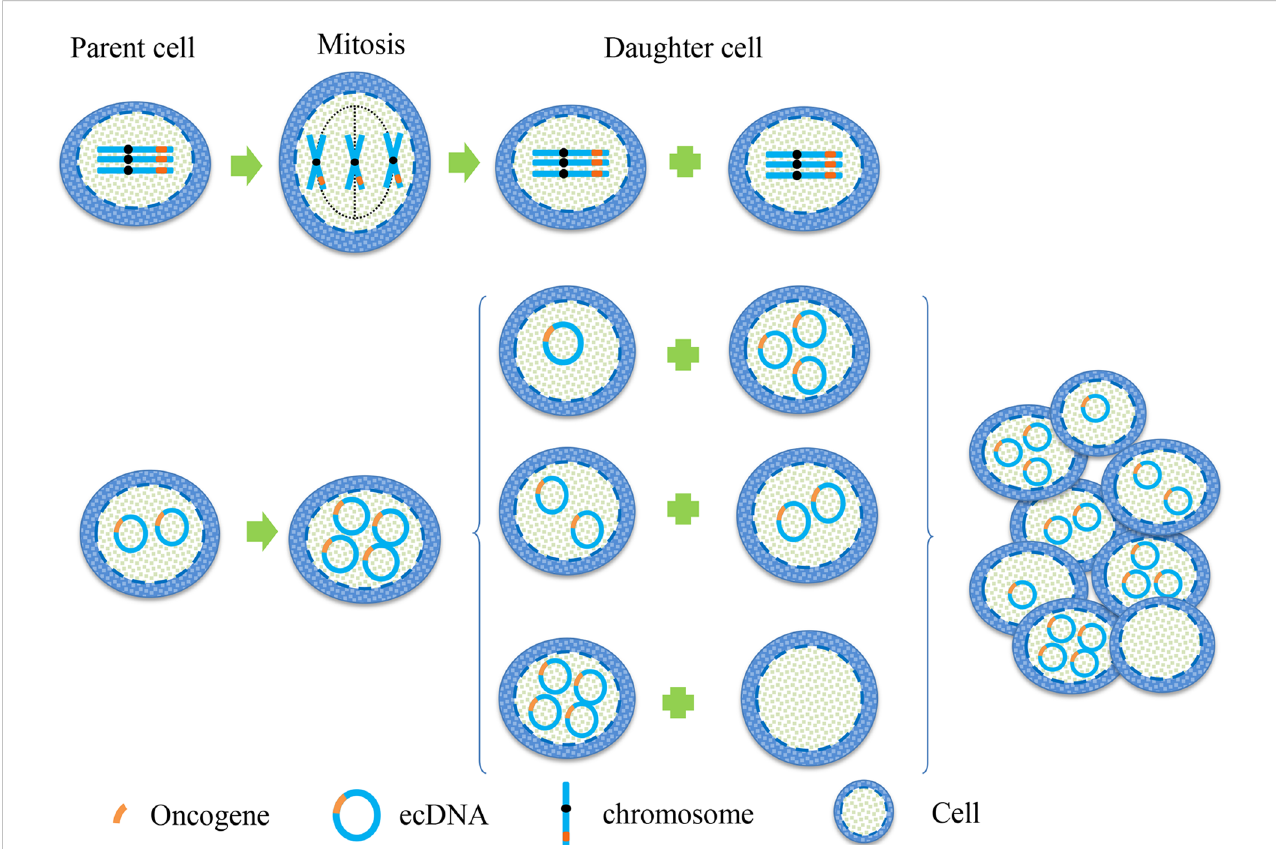
FIGURE 1 Hereditary difference between chromosome and eccDNA. When the oncogene is on a chromosome, the two sister chromatids are separated by pulling the centromere by the spindle during mitosis, and then they were equally distributed between the two daughter cells. This is a classic example of Mendel ’ s Law. When the oncogene is located on eccDNA, eccDNA replicates with the chromosome during mitosis. Because eccDNA has no centromere, the separation of eccDNA is not controlled by the spindle, resulting in the copied eccDNA being randomly assigned to daughter cells during cell division. This unique genetic mode makes the number of eccDNA in each cell unequal, leading to heterogeneity of eccDNA in each cell